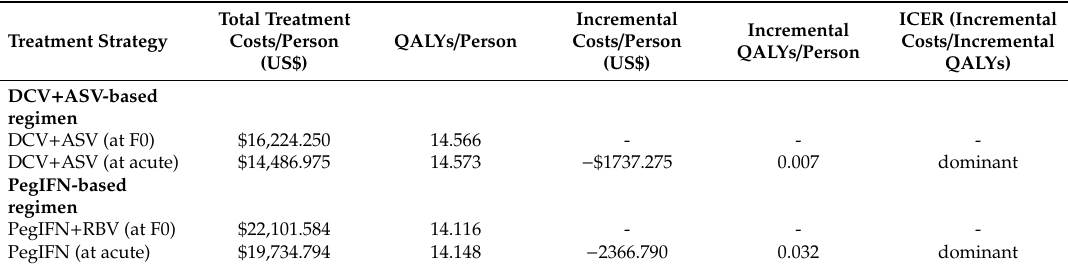
Table 1. Costs, QALY, and ICER of treating acute HCV compared with delayed to F0 stage under DCV + ASV and PegIFN-based